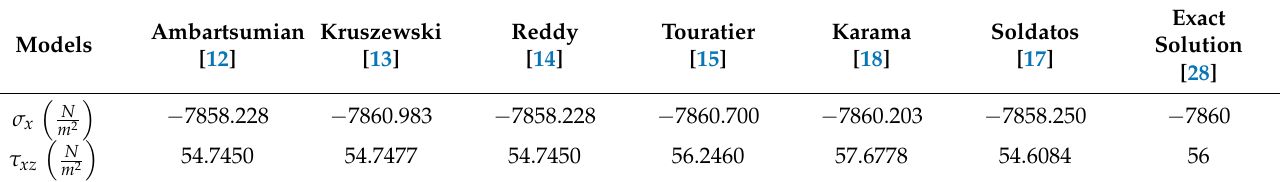
Table 4. Axial stress σ x at ( x = L /2, z = − h /2 ) and transverse shear stress τ xz at ( x = L /4, z = 0 ) for high order shear deformation models of piezoelectric beams with aspect ratio S = 30.